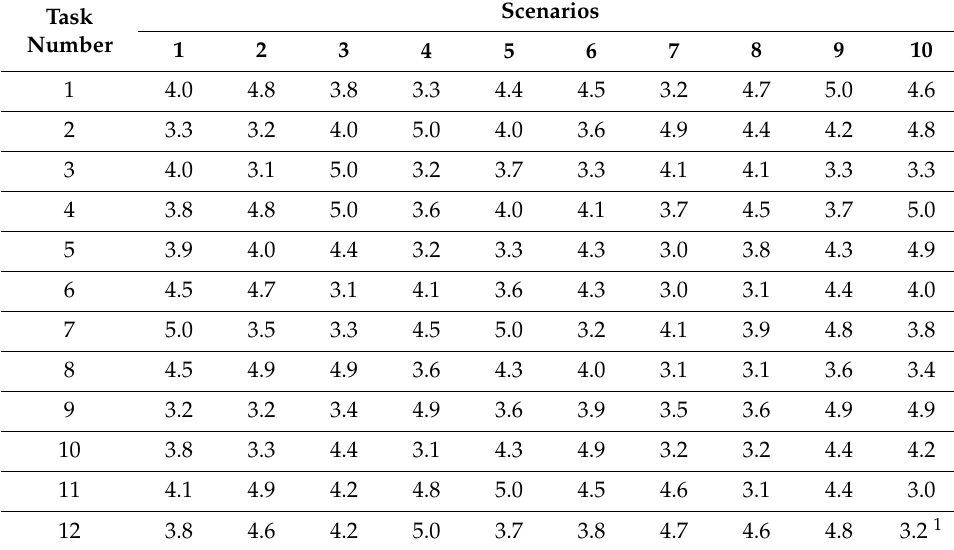
Table 1. Assembly operation data for 10 di ff erent